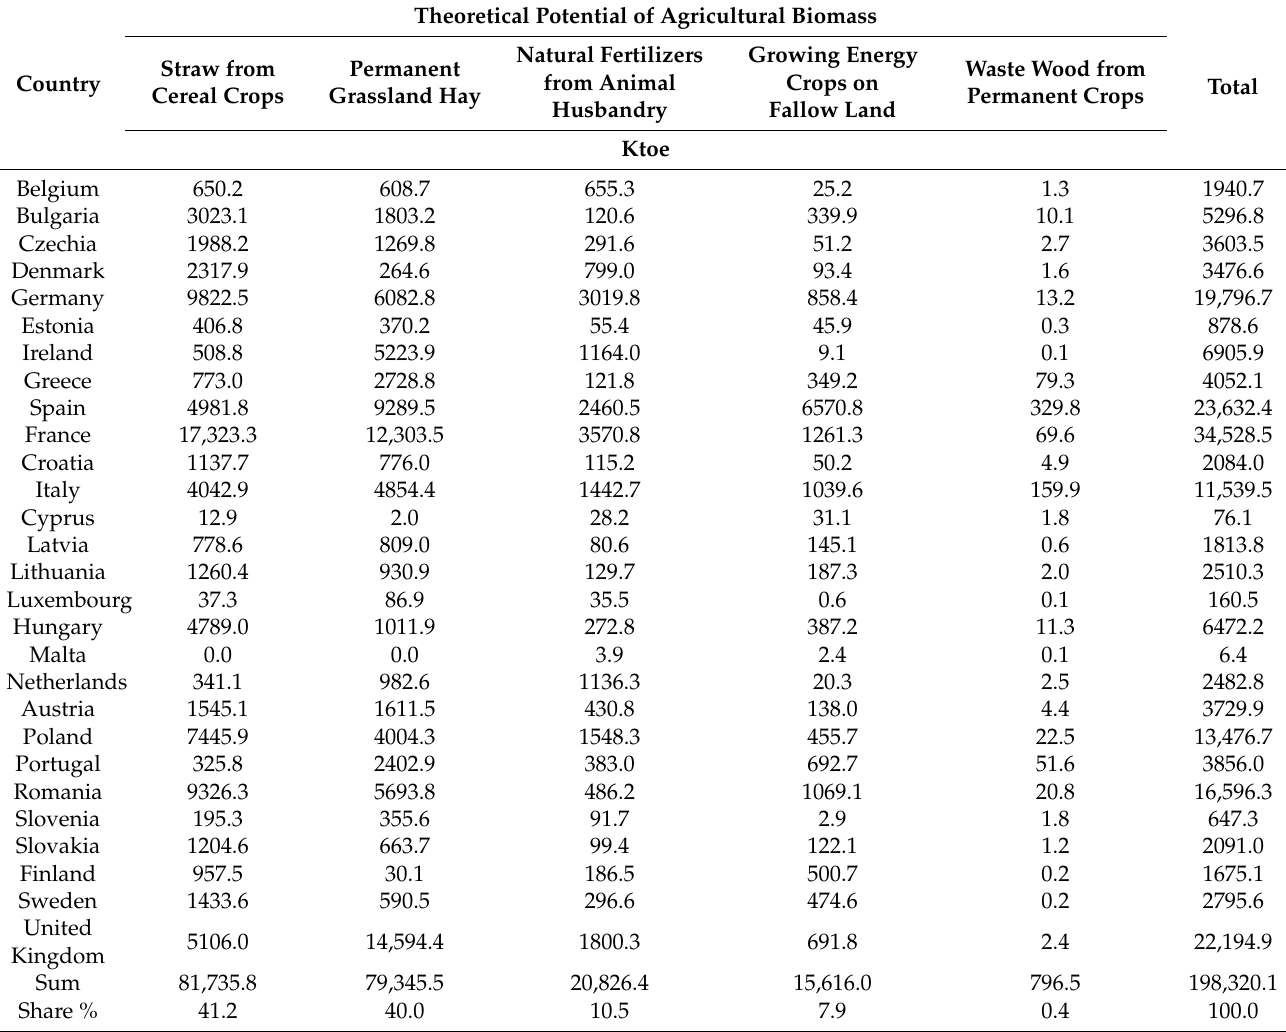
Table 2. The theoretical potential of agricultural biomass in EU countries in 2019.